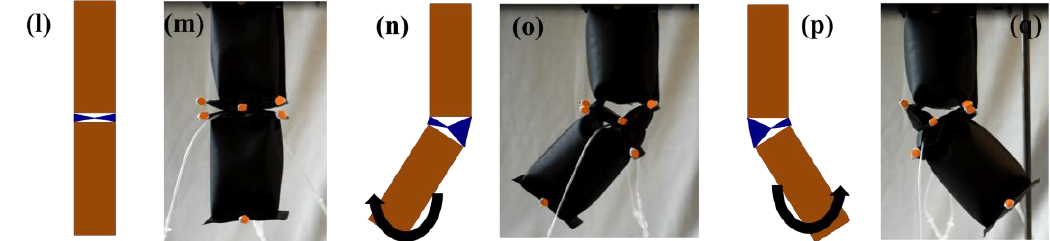
Figure 2. ( a ) One FRA module in depressurized (inactive) state and pressurized (active) state. ( b – q ) show assemblies with different configurations of FRA modules with IB modules and the active and inactive states of the assemblies. Active state refers to pneumatic pressurization of FRA module, which rotates the assembly. ( b – e ) One FRA module and two IB modules (SNG assembly), ( f – k ) two FRA modules connected in series and two IB modules (SRS assembly), ( l – q ) two FRA modules connected in parallel and two IB modules (PLL assembly).